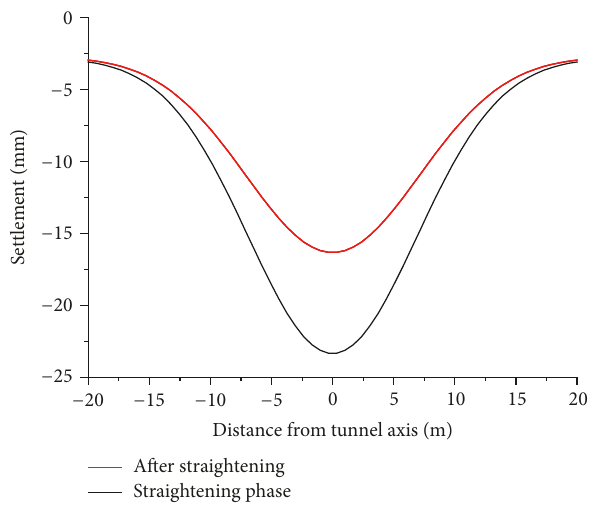
Figure 9: Surface settlement calculation